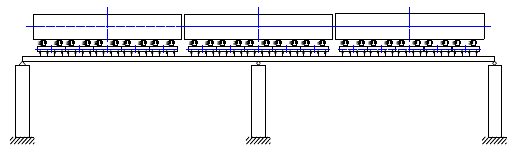
Fig. 1 Dynamic simulation analysis model